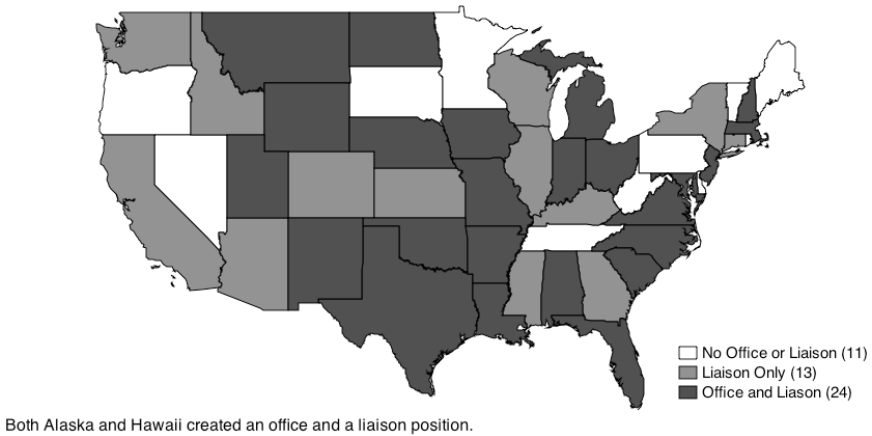
Figure 1. State creation of offices of faith ‐ based and community initiatives and faith ‐ based liaisons 1996–2009.